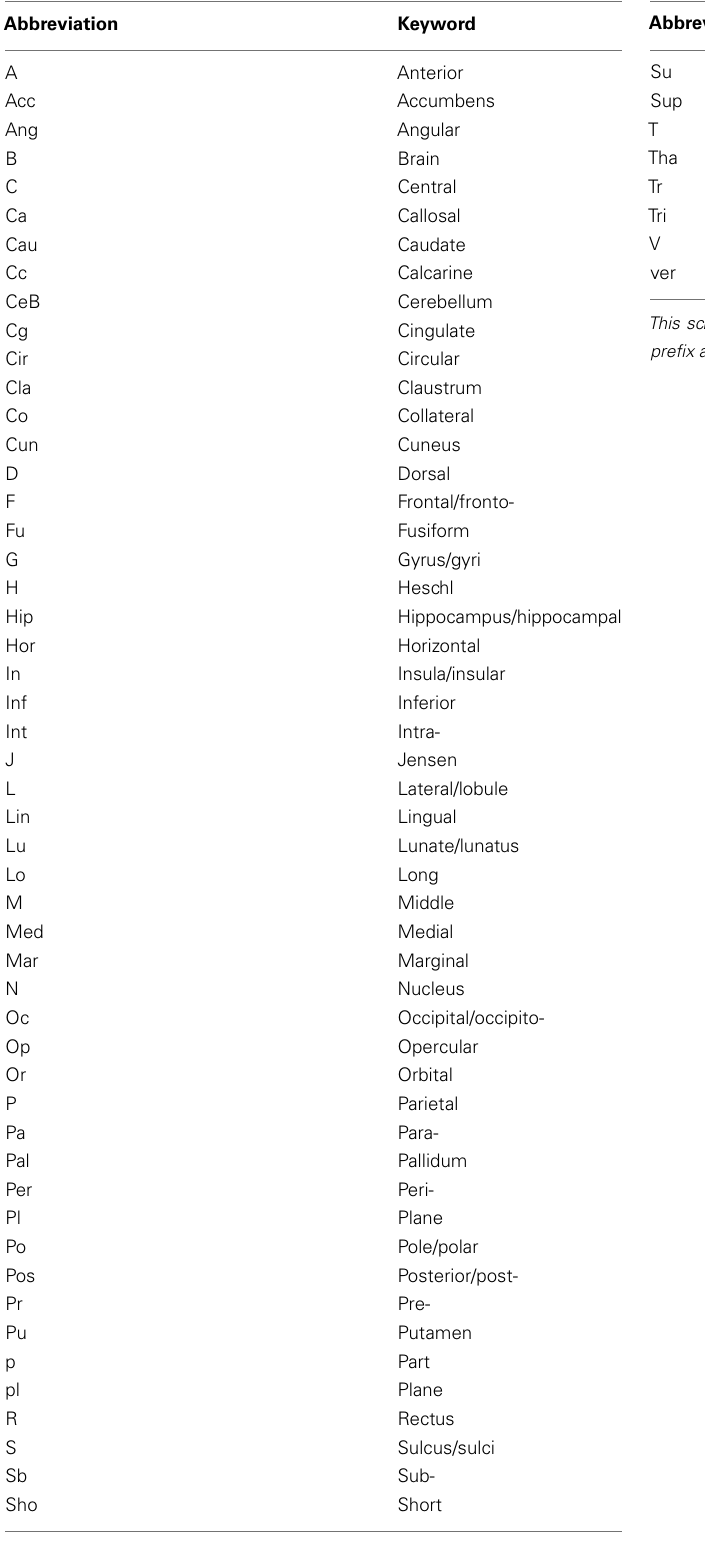
TableA2 |Abbreviations for cortical parcelations used in